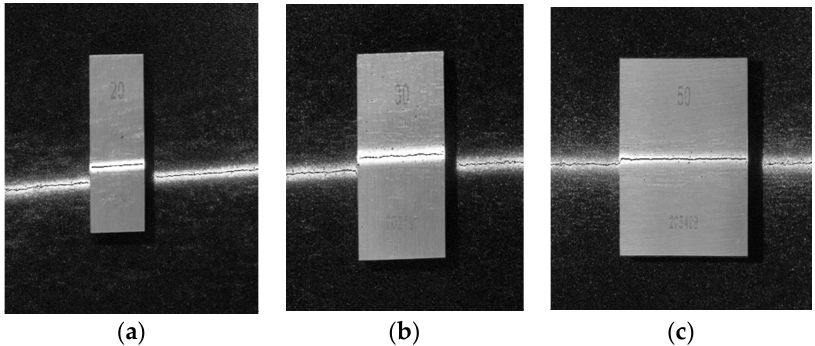
Figure 9. Extraction results of light stripe center of standard gauge blocks with different specifica- tions: ( a ). Extraction results of light stripe center of 20 mm standard gauge block; ( b ). Extraction results of light stripe center of 20 mm standard gauge block; ( c ). Extraction results of light stripe center of 20 mm standard gauge block.